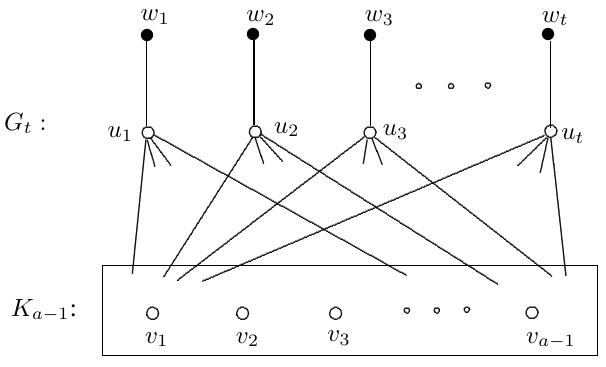
Figure 4: The graph G